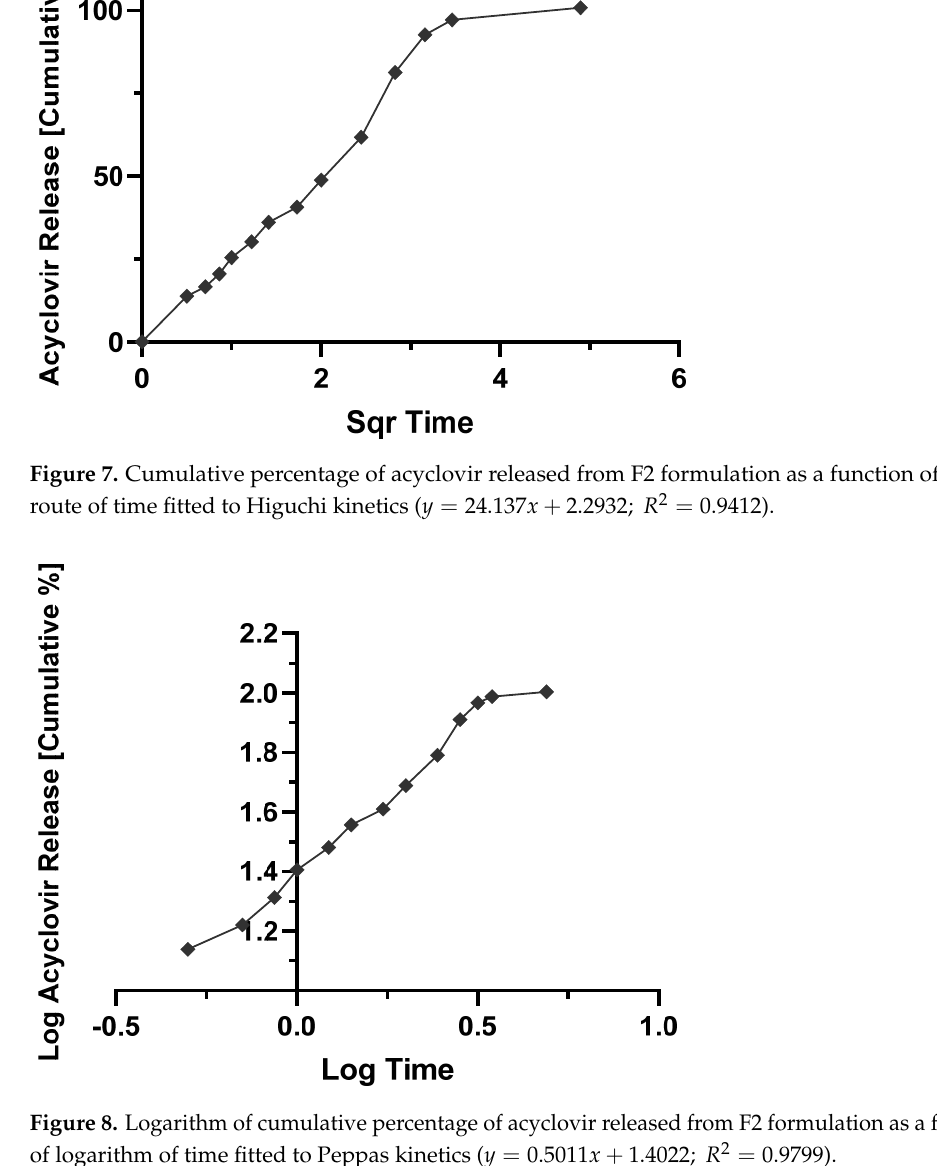
Figure 8. Logarithm of cumulative percentage of acyclovir released from F2 formulation as a func- tion of logarithm of time fitted to Peppas kinetics ( 𝑦 = 0.5011𝑥 + 1.4022; 𝑅 (cid:2870) = 0.9799 ).